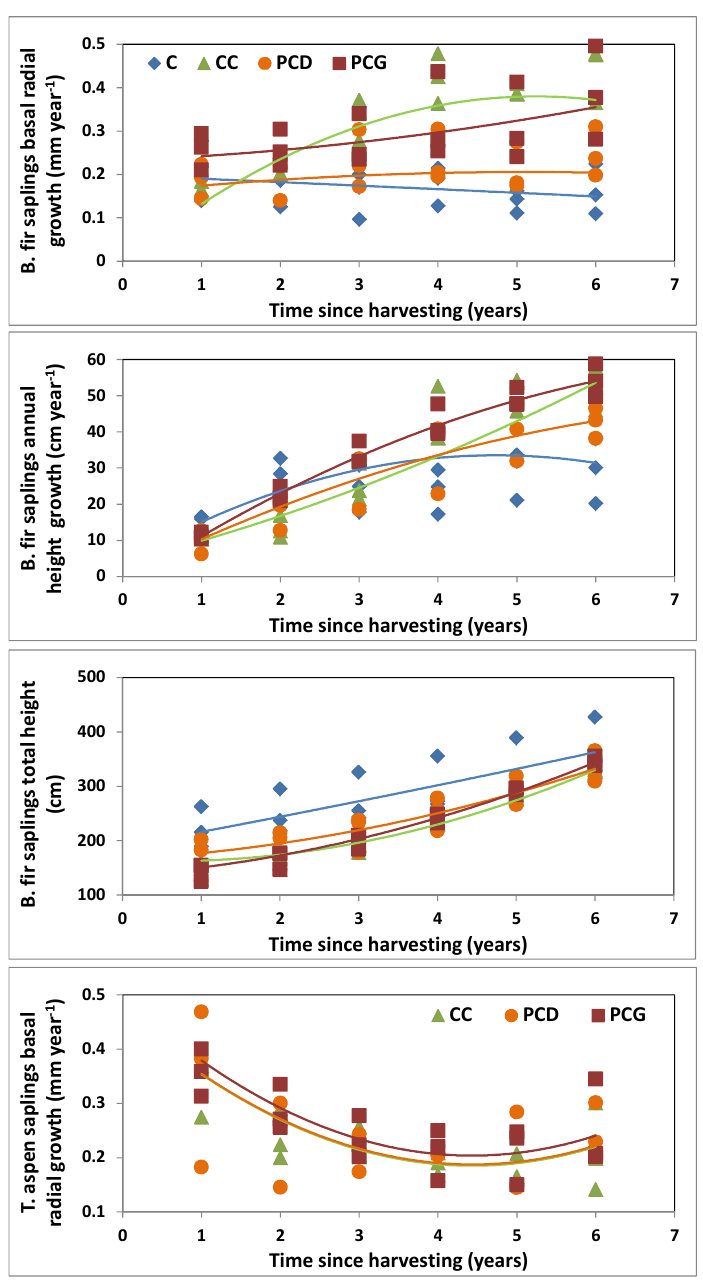
Figure 4. Balsam fir and trembling aspen small saplings growth in mixed boreal stands as a function of treatment and time since harvesting. Points are average observed values over experimental blocks. Lines are predicted values according to models (see Table 2 for model specifications). Control stands observed values for trembling aspen are not